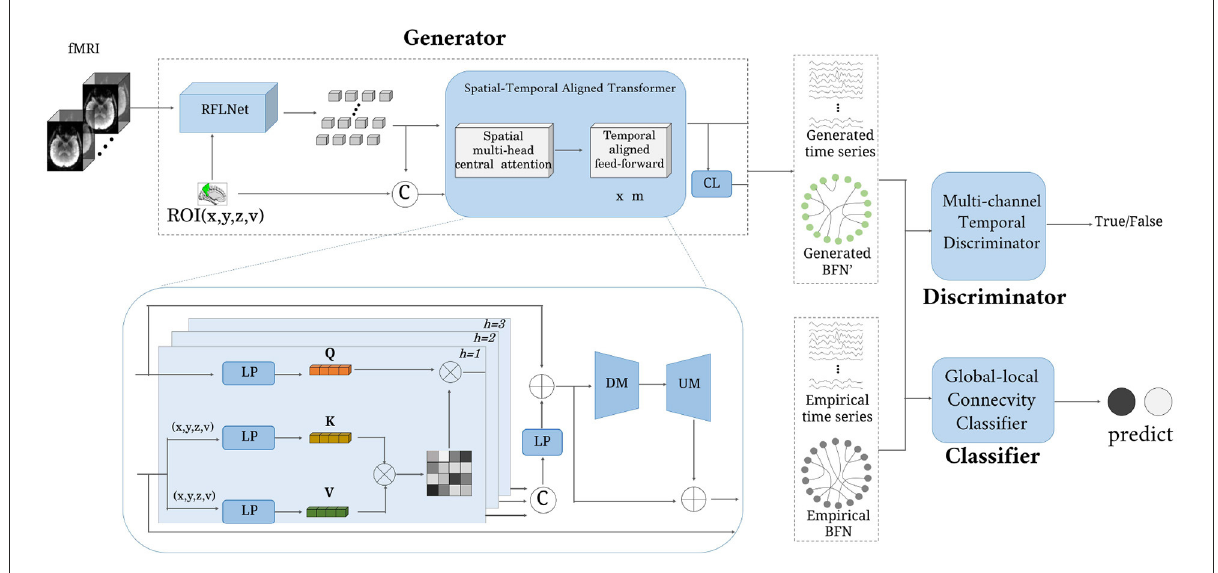
FIGURE1 The framework of the proposed model. It consists of three parts: generator, discriminator, and classifier. The input is a four-dimensional fMRI, and the output is a brain functional